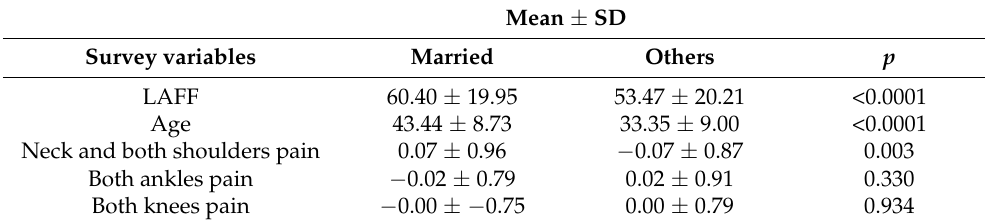
Table 4. Leisure Activities, Age, and Pain Characteristics Stratified by Marital Status.